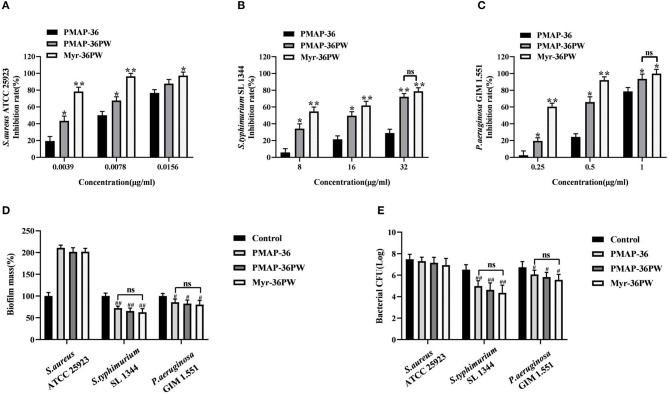
Biofilm inhibition and eradication of Myr-36PW. (A–C) Inhibition of biofilm formation by Myr-36PW. (D) Eradication of preformed biofilm by Myr-36PW. (E) Killing effect of Myr-36PW against biofilm bacteria. Inhibition rate % = [1 – OD620 nm(peptides)/OD620 nm(bacteria)] × 100%. Biofilm mass % = OD620 nm(peptides)/OD620 nm(control) × 100%. The control group was bacterial culture without peptides. Data represent the mean ± SD (n = 5). The number of bacteria (CFU) was displayed in the form of Log. *P < 0.05 and **P < 0.01, compared with PMAP-36. #P < 0.05 and ##P < 0.01, compared with control. ns denotes no significance.